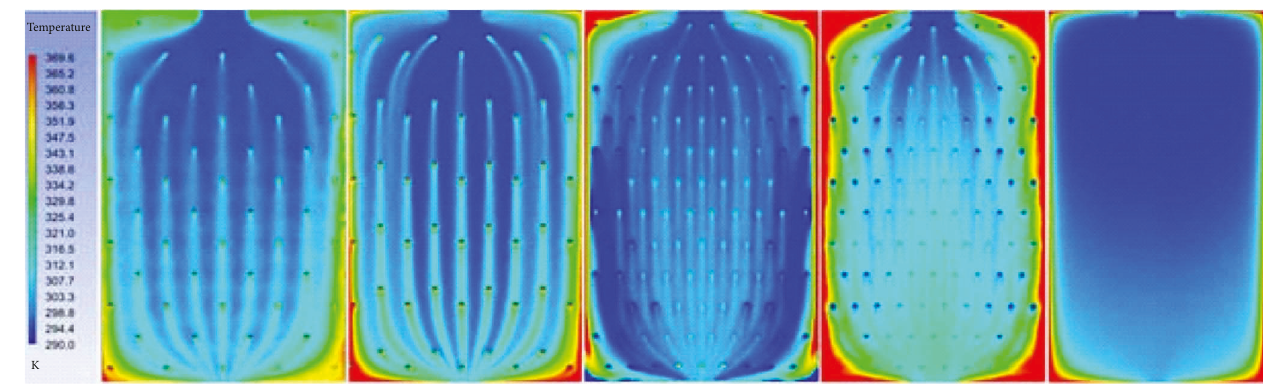
Figure 17: Temperature contours at 4.5m/s.